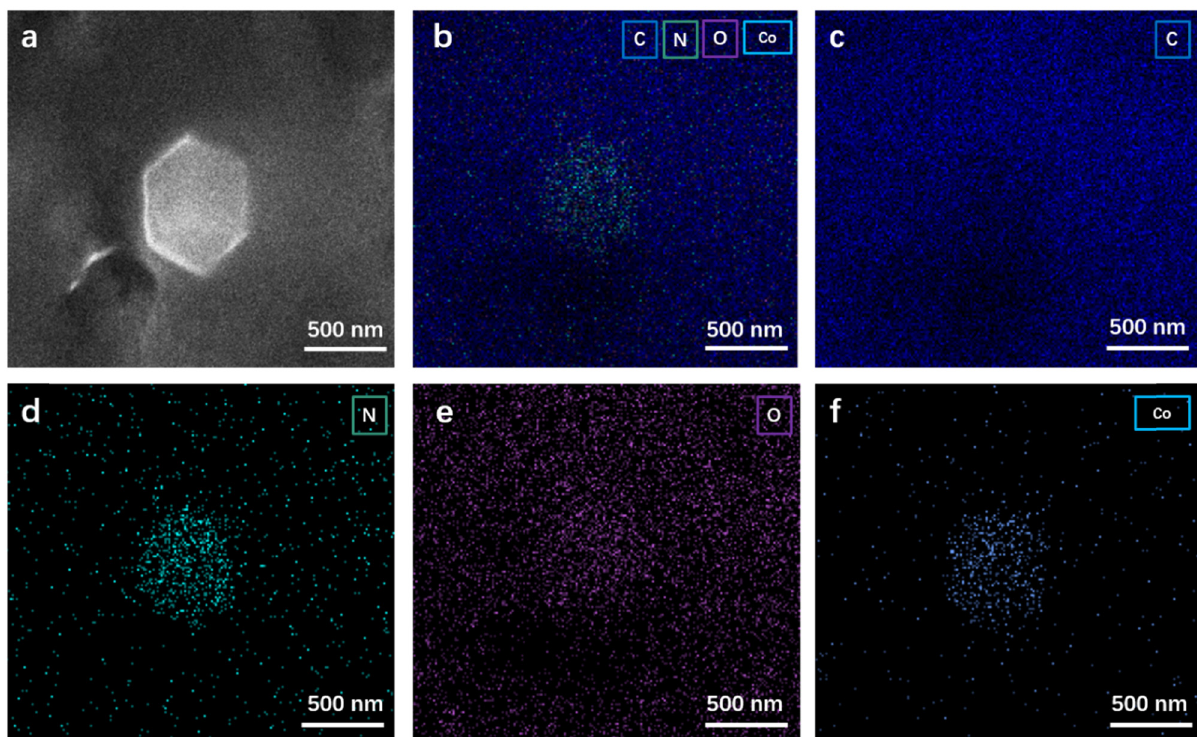
Figure A2: SEM image ( a ) and corresponding element mappings of ( b ) ZIF - 67@EP, demonstrating the distributions of ( c ) C, ( d ) N, ( e ) O and ( f )